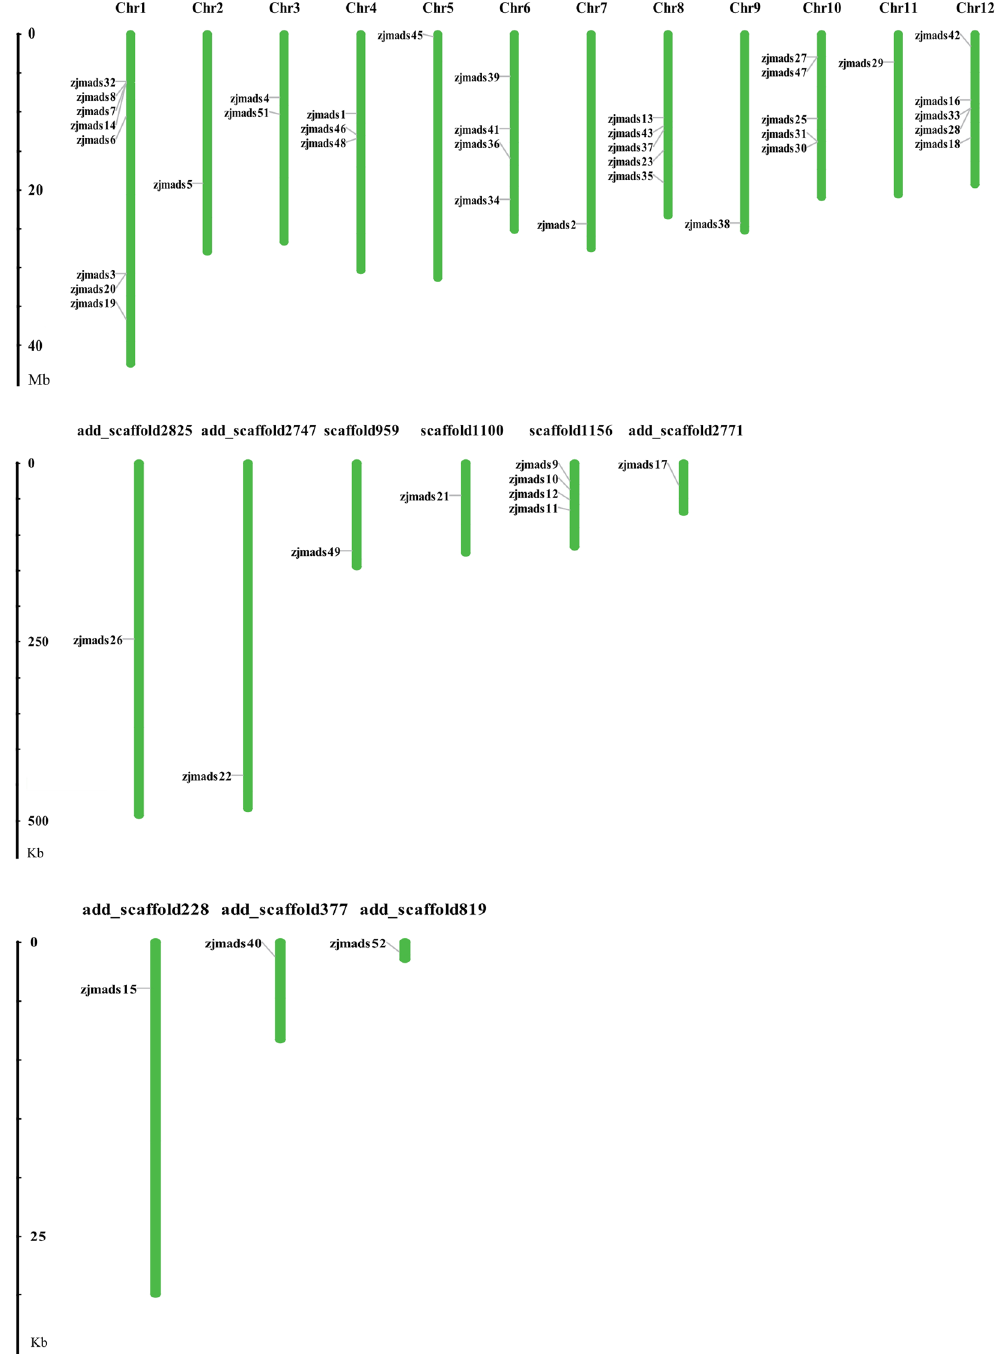
Figure 4. Positions of ZjMADS genes on the jujube pseudo-chromosomes or